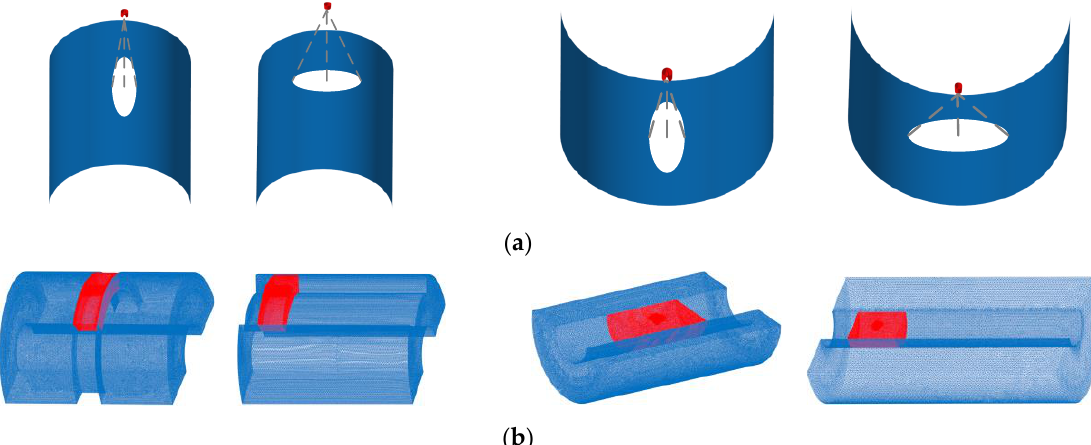
Figure 4. Computational domain and mesh division of the arc surface spraying. ( a ) Computational